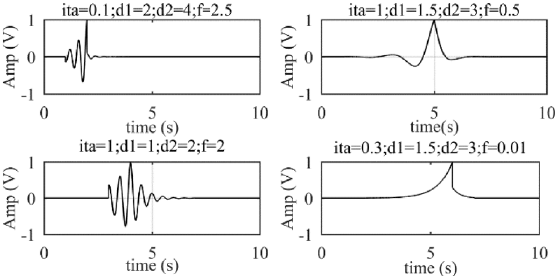
Figure 4. Time domain waveforms of t r -atoms with different parameters. ‘ita’ represents